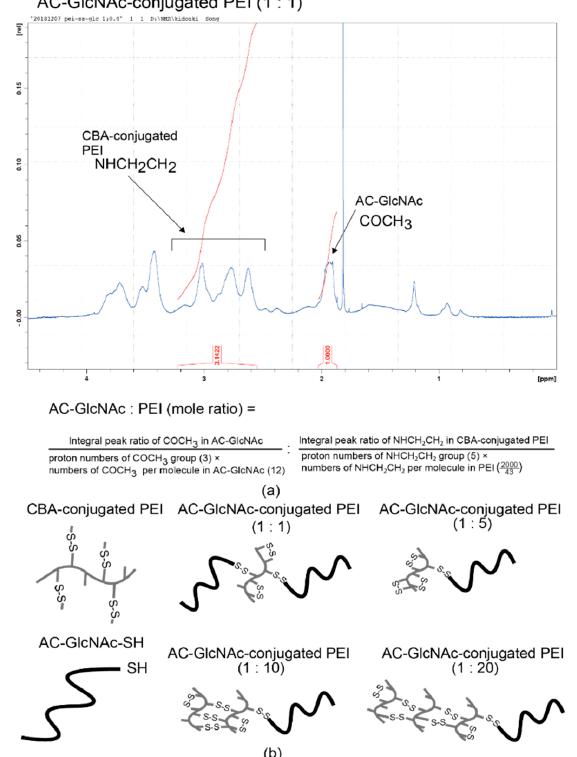
Figure 2. Nuclear magnetic resonance (NMR) charts and schemes of AC-GlcNAc-conjugated polyethyleneimine (PEI). ( a ) NMR charts of AC-GlcNAc-conjugated PEI (1:1). ( b ) Schemes of AC-GlcNAc-conjugated PEI (1:1, 1:5, 1:10, and 1:20) .